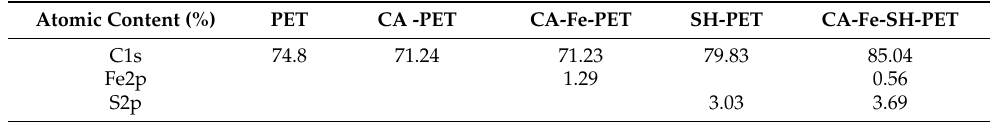
Table 1. Atomic element percentages of PET, CA-PET, CA-Fe-PET, SH-PET, and CA-Fe-SH-PET.